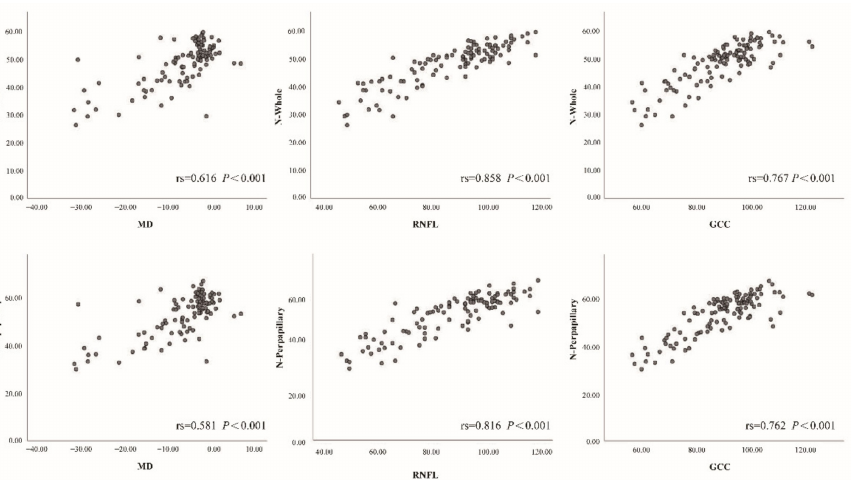
Figure 5. Relationships of whole image vessel density (N-Whole) and peripapillary vessel density (N-Perpapillary) with VF mean deviation (MD), mean retinal nerve fiber layer (RNLF), and ganglion cell complex thickness (GCC) in all